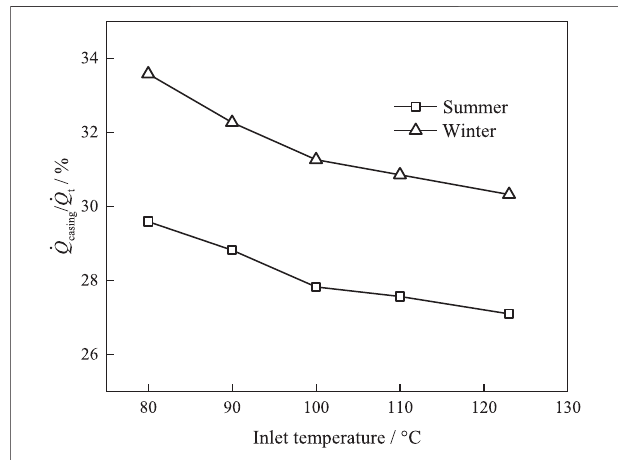
FIGURE10| Thevariationofheatloss proportionwithinlettemperature.